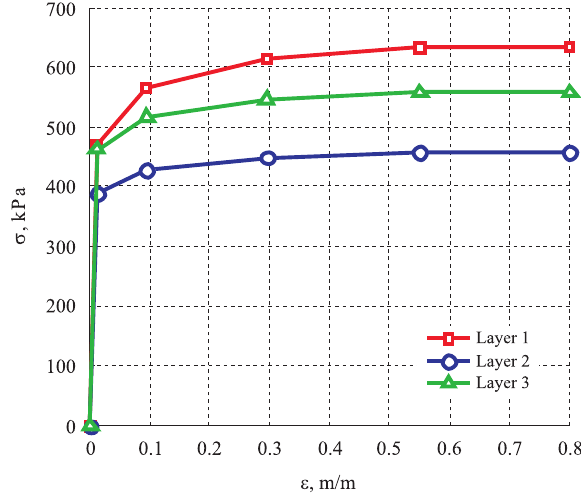
Fig. 4. Nonlinear physical models MKIN of the materials